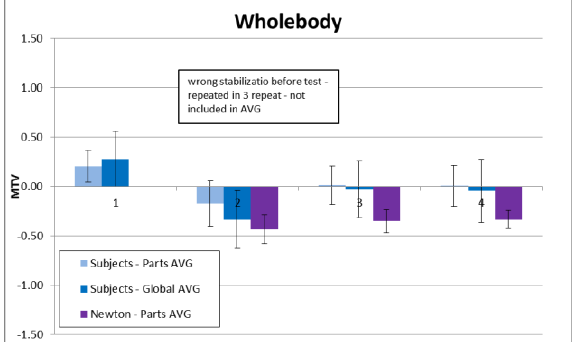
Fig. 7. Winter conditions evaluation of human subjects’ tests – Wholebody MTV for all subjects N.1-10.